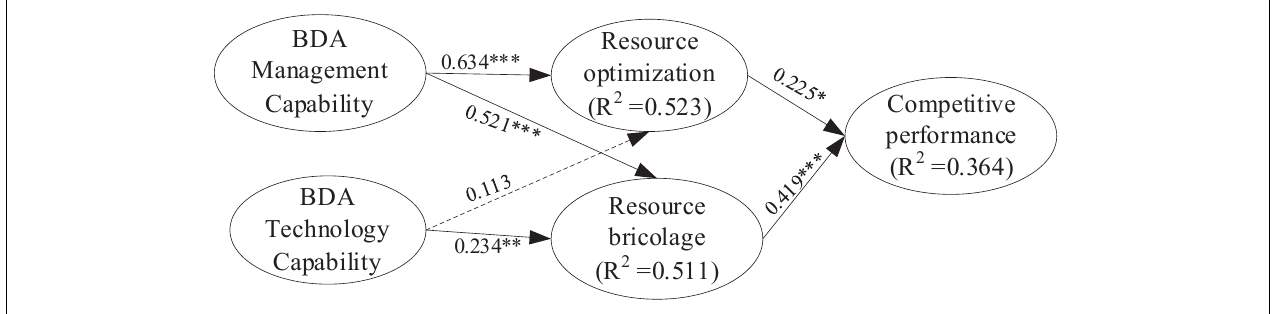
FIGURE 2 | PLS path model. ∗ p < 0.05, ∗∗ p < 0.01, ∗∗∗ p < 0.001.